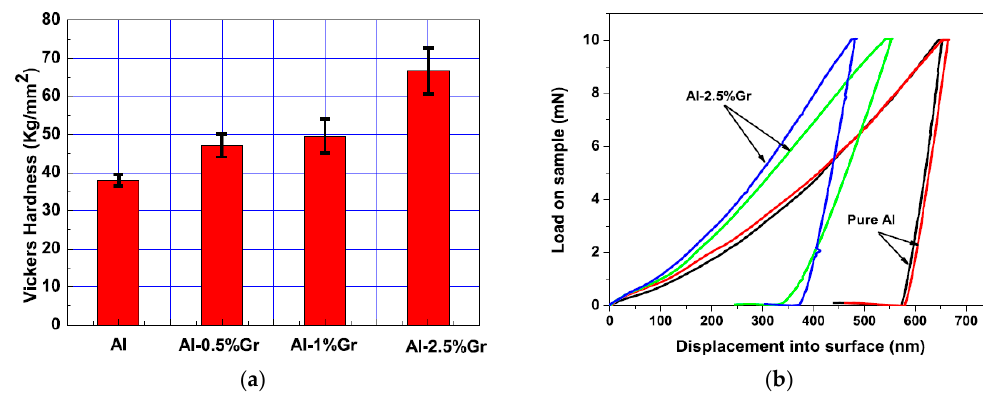
Figure 5. Transmission electron microscopy (TEM) and high-resolution transmission electron microscopy (HRTEM) images of Al/GNPs composites: ( a ) TEM image shows rod aluminum carbide with corresponding selected area diffraction (SAED) patterns, ( b ) graphene, Al, aluminum carbide area and their interface [121], Reproduced from [121], with permission from Elsevier, 2018.